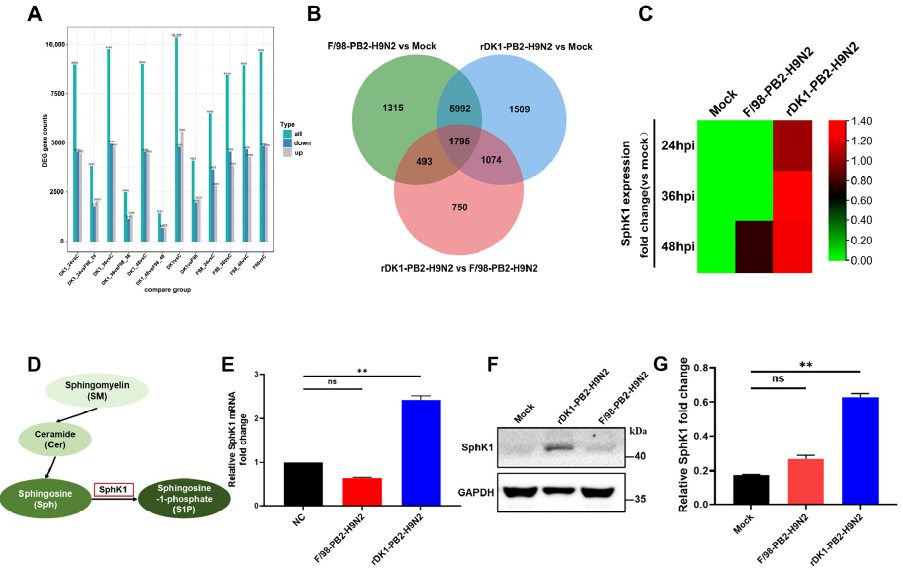
Figure 3. Transcriptomic screening for key differentially expressed host SphK1 gene. ( A ) The number of differential genes in each group was obtained by transcriptomic detection. Blue and gray represent up-regulated and down-regulated differential genes, respectively, and the numbers on the columns represent the number of differential genes; ( B ) Venn diagram of the number of differential genes compared between different groups, with different colors indicating different combinations of comparisons; ( C ) fold change value of SphK1 gene after influenza virus infection compared with the Mock group, presented as a heat map, the darker the red color, the larger the value; ( D ) schematic diagram of the role of SphK1 in cellular metabolism; ( E ) A549 cells were infected with the virus at MOI = 0.2, Cells were collected 24 h after infection to detect the mRNA expression of SphK1; ( F ) A549 cells were infected with the virus at MOI = 0.2, and the cells were collected 24 h after infection to detect the expression of SphK1 protein, glyceraldehyde-3-phosphate dehydrogenase (GAPDH) was used as a loading control. ( G ) for ( F ) densitometry analysis quantification. Differences were considered statistically significant at p < 0.05 (** p < 0.01, ANOVA).